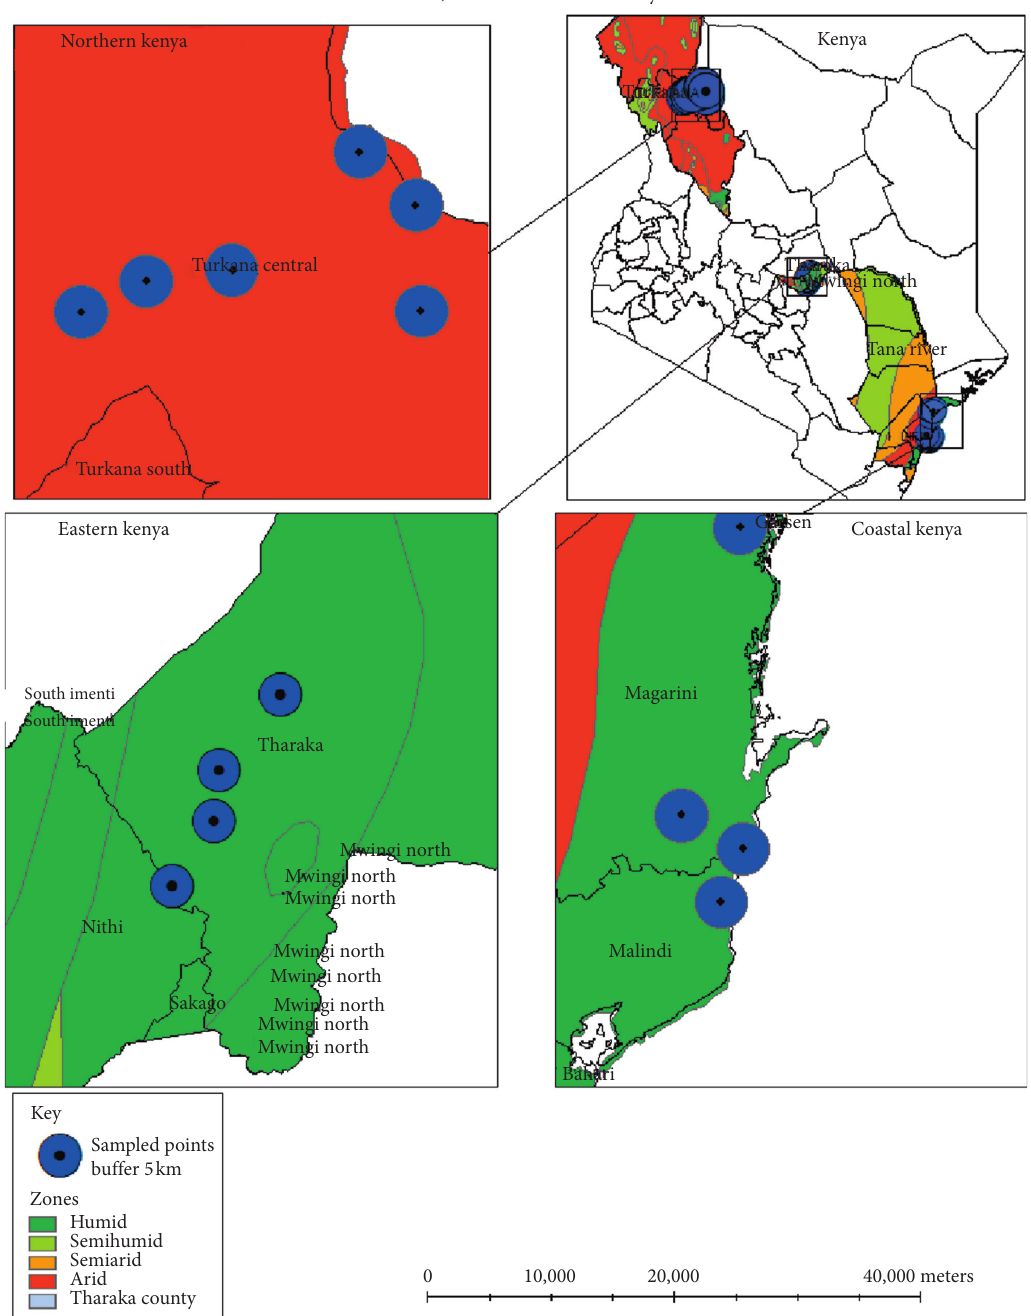
Figure 1: Sampling points in the different counties of Kenya from which Hyphaene compressa (doum palm) accessions were collected in